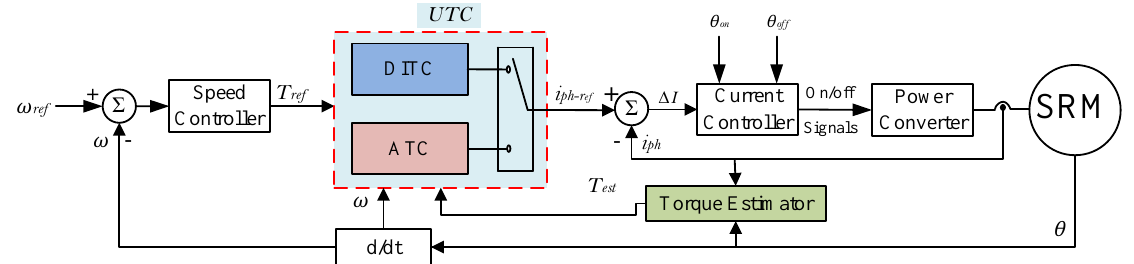
Figure 5. The universal torque control (UTC) of SRM.